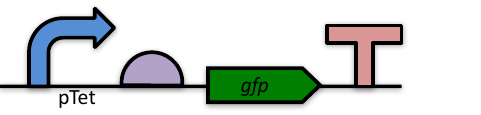
Figure 24: DNA sequence for a functional unit in which the pTet promoter and an anonymous ribosome entry site regulate expression of a coding sequence for GFP, ended by a terminator.